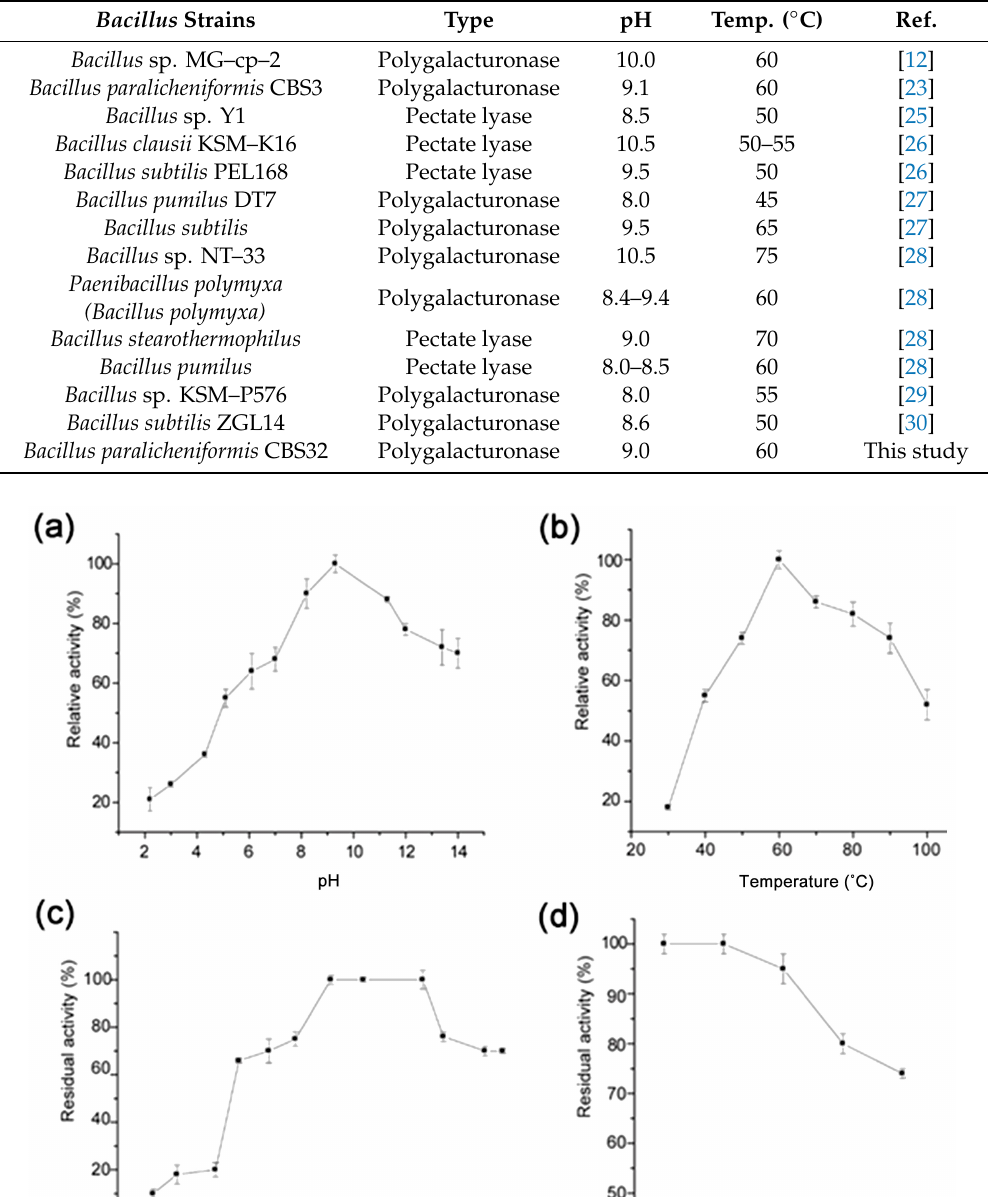
Table 2. Comparison of PN32 to similar alkaline pectinase from Bacillus strains.